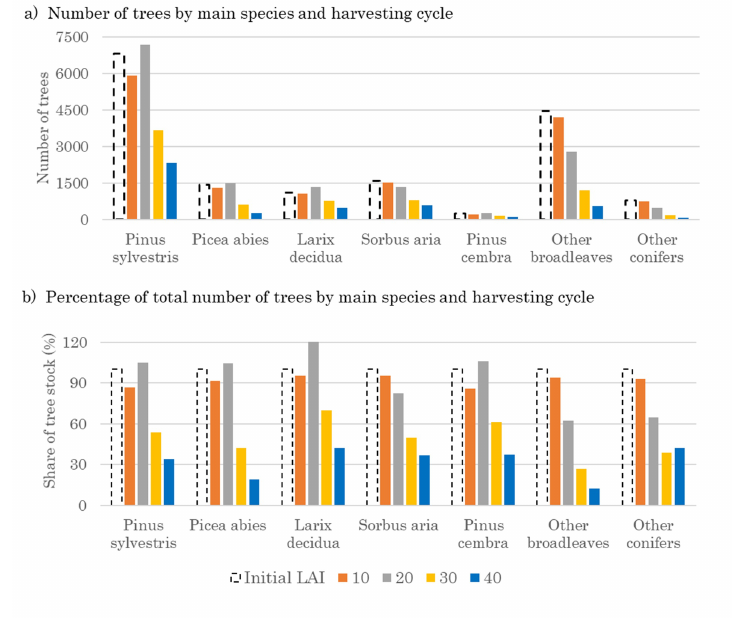
Figure 6. Relative changes in the number of trees by species (Results for the joint timber and water (TW) benefits maximization scenario, a discount rate 4%, maximum harvesting rate ( η ) of 0.5, and a time horizon 40 years).